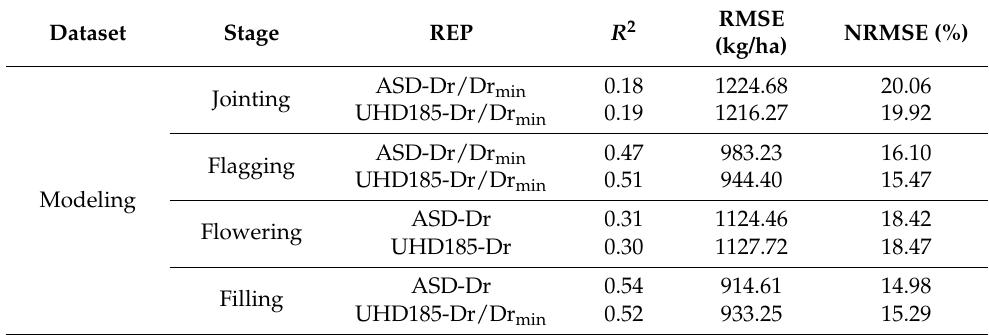
Table 5. The relationships between the yield and the optimal red-edge parameters (REPs) at different growth